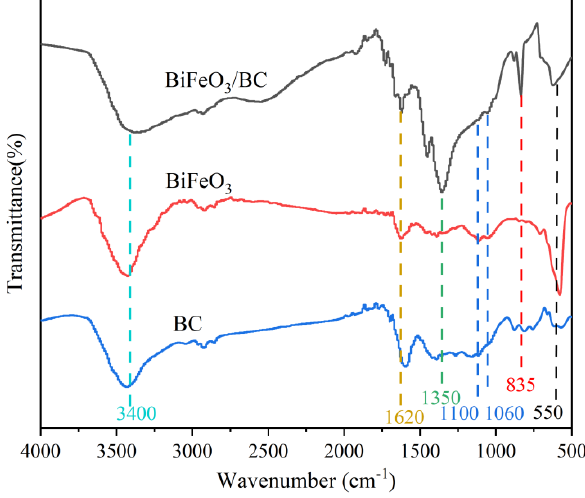
Figure 2. FT-IR spectroscopy of BC, BiFeO 3 /BC, and BiFeO 3 .